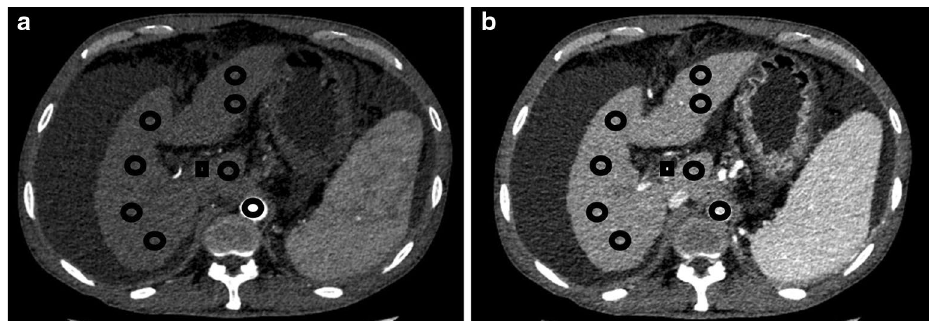
Figure 1. Regions of interest (ROIs) measurement of quantitative indices. Multiple ROIs were placed in liver parenchyma (circle ROI), aorta (circle ROI) and portal vein (square ROI) in arterial phase ( 1a ) and venous phase ( 1b ), with average area about 100 mm 2 , respectively. The averages were calculated as the iodine